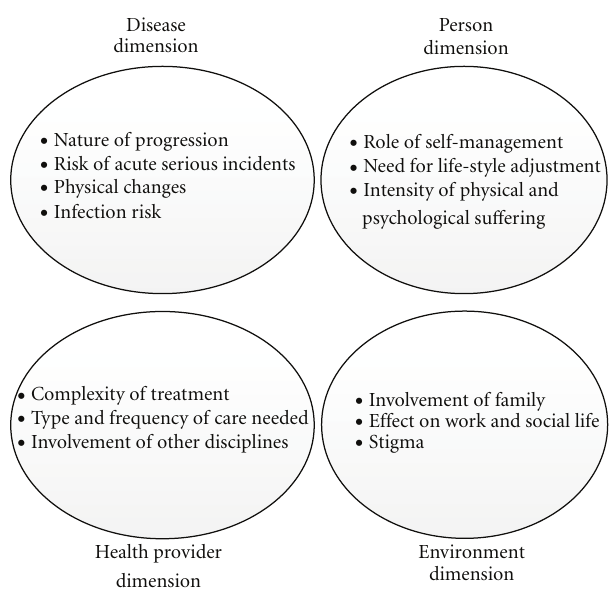
Figure 1: The “Chronic Dimension Framework” to describe four dimensions of chronic